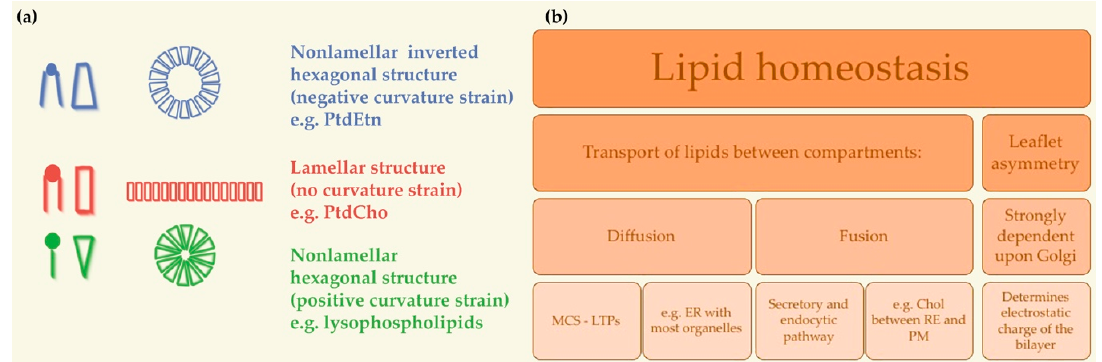
Figure 3. Membrane homeostasis and circuits of lipids between organelles. ( a ) Lipid bilayers can form a number of different structures upon their composition in PL species. Some examples of lipid shapes and their influence on membrane structure are shown. Lipids with a small polar head (blue), such as PtdEtn, have a molecular shape that resembles a truncated cone. They induce a negative curvature strain. Lipids with a bulky polar head and only one acyl chain (e.g., lysophospholipids, green) have a molecular shape similar to an inverted cone and induce a positive curvature strain in membranes. Lipids such as PtdCho have similar cross-sectional areas for the polar head and hydrophobic region and resemble cylinders (red). They form lamellar phases, with no curvature strain. Not to scale. Adapted from [113]. ( b ) Mechanisms of lipid homeostasis maintenance between cell compartments. Chol: cholesterol; ER: endoplasmic reticulum; MCS: membrane contact sites; LTPs: lipid transfer proteins; PM: plasma membrane; PtdCho: phosphatidylcholine; PtdEtn: phosphatidylethanolamine.